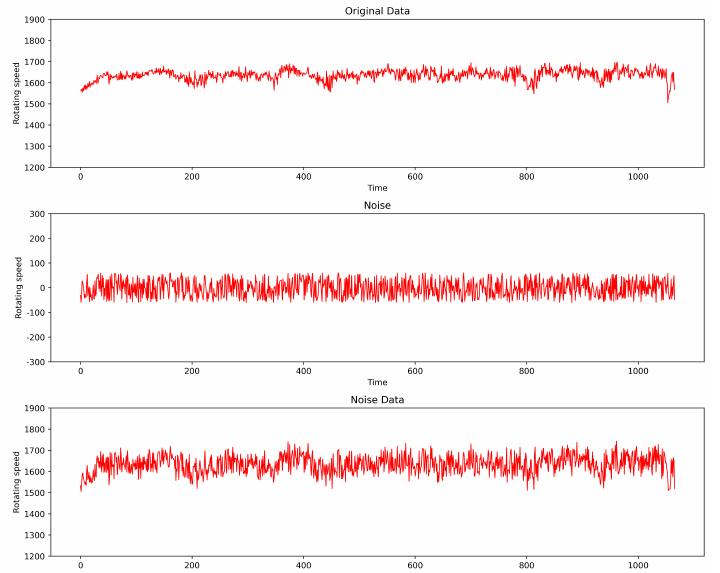
Figure 18. Original UAV data, noise data to be added, and final synthesized data containing Gaussian white noise.